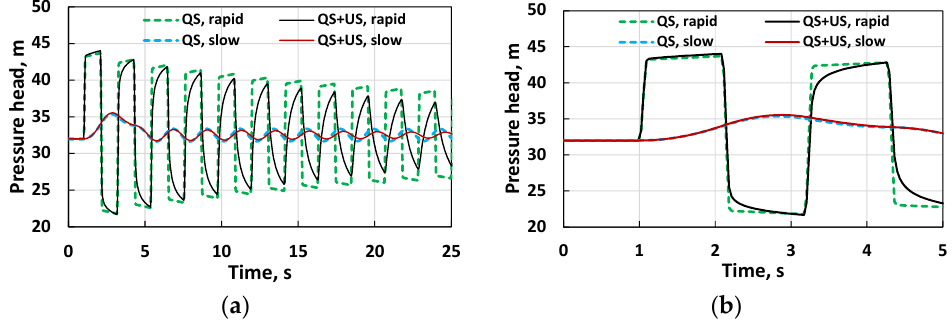
Figure 3. Influence of skin friction on simulated pressures in an unsteady, turbulent, pipe flow induced by rapid and slow valve closures. ( a ) Progressive decay. ( b ) Detailed form.